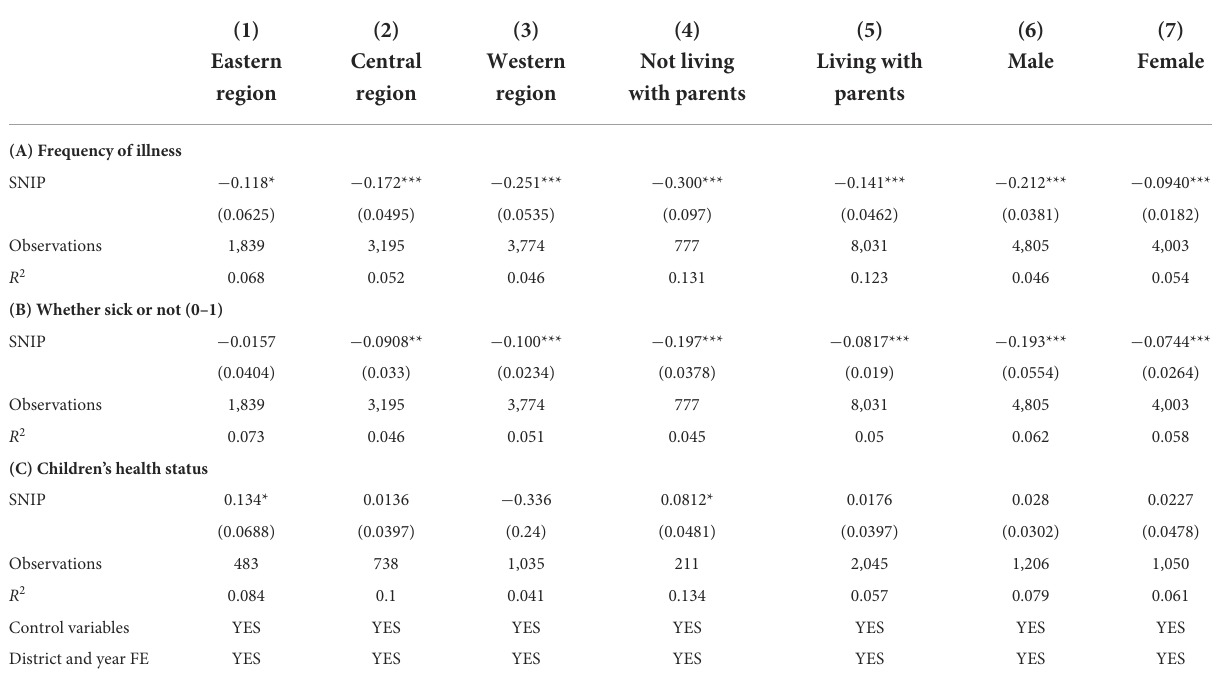
TABLE 5 Heterogeneity